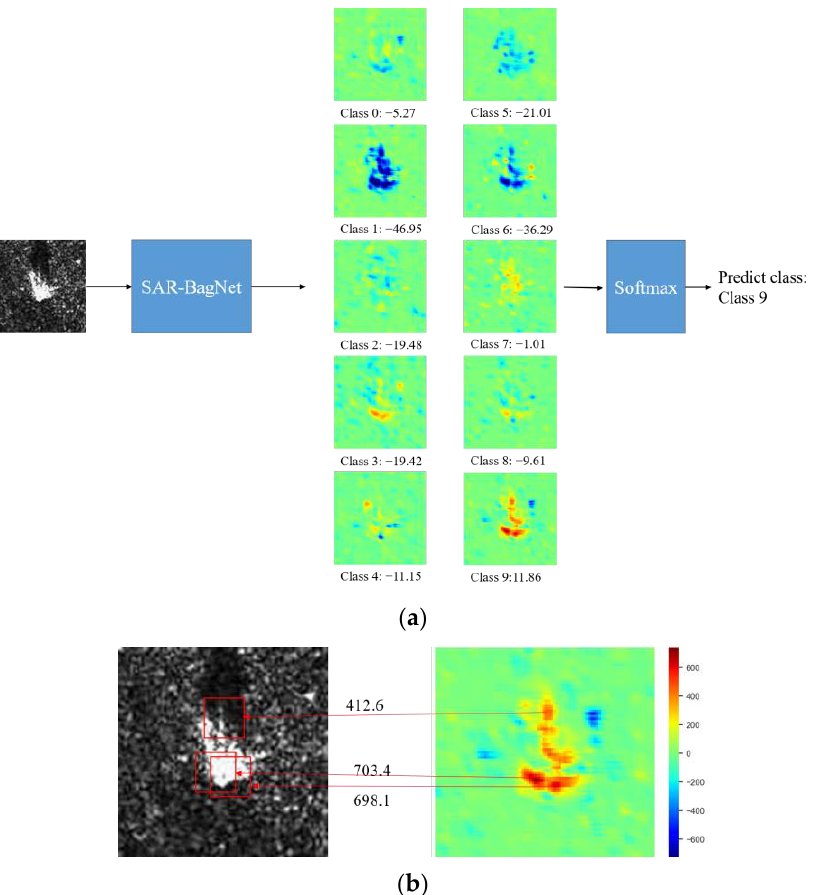
Figure 6. Recognition process of SAR-BagNet. ( a ) Schematic diagram of SAR-BagNet recognition process; below the heatmaps are the corresponding class and average value. ( b ) Patches in the SAR image corresponding to areas with larger values in the